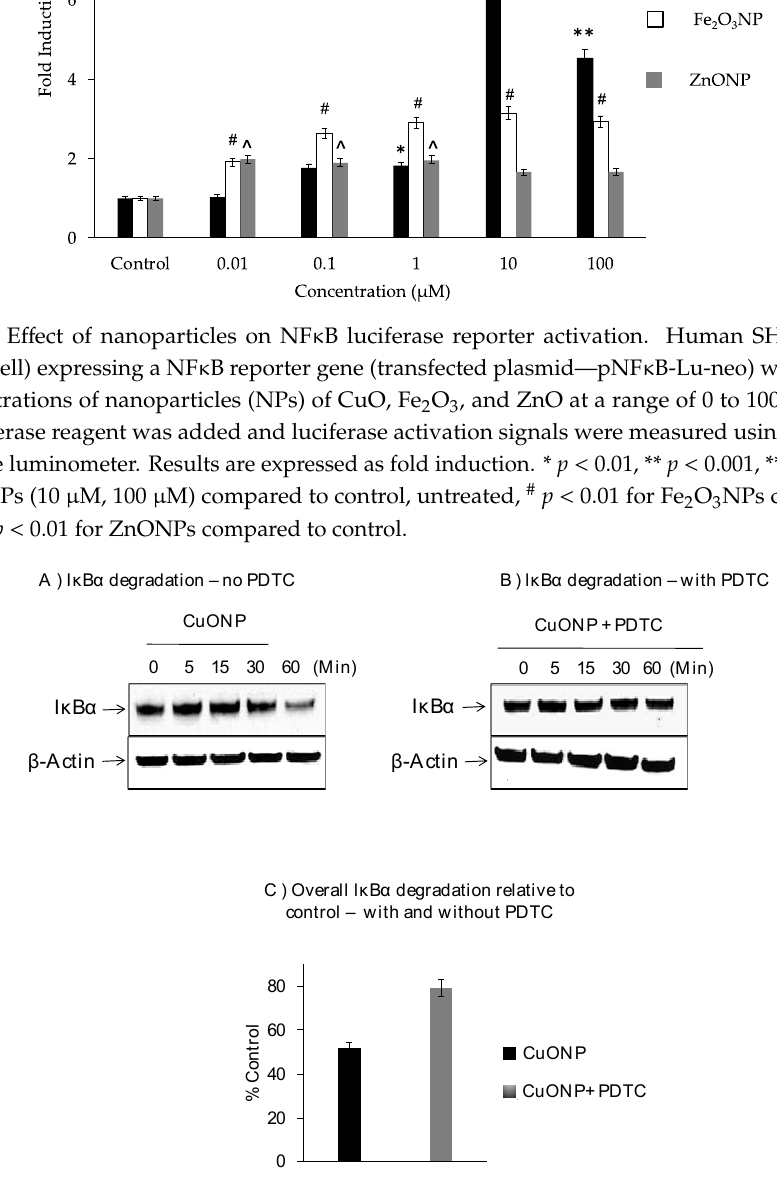
Figure 2. Effect of CuONPs on I ĸ B- α degradation. SH-SY5Y cells were plated at 2 × 10 6 cells/well (6 well plate) and exposed to CuONPs (10 μ M) in the presence or absence of the potent NF κ B inhibitor—pyrrolidine dithiocarbamate (PDTC, 50 nM) at the indicated time points. Cells were lysed, and lysates were Western blotted for the presence of I κ B- α —a protein inhibitor for NF κ B activation. Blots were collected, digitized, and quantified using a Bio-Rad VersaDoc™ Digital Imaging System (MP4000). Experiments were performed at n = 3 independent trials and representative Western blots were presented. ( A ) Western blot from cells exposed to CuONPs but not PDTC; ( B ) western blot from cells exposed to CuONPs and PDTC; ( C ) summary graph of relative degradation (compared to controls) in cells exposed to CuONPs and CuONPs and PDTC. The influence of CuONPs on APP expression was analyzed by administering treatment for 72 h on SH-SY5Y cells. The levels of APP expression were increased up to 5-fold during 6 to 24 h time periods, declining thereafter with a dose level of 10 μ M (Figure 3A). No change in the protein concentration of β - actin indicated specificity. The effects of the CuONP dose (0.01–100 μ M) on APP protein expression after 6 h of exposure in SH-SY5Y and PC12 cells were detected. TNF α (50 ng/mL) was used as a control for APP induction, and higher levels (10–100 μ M) of CuONPs resulted in increased APP expression in SH-SY5Y and PC12 cells (Figure 3B). CuONPs of 10 μ M increased APP in both cell types (SH-SY5Y and PC12). However, a 4-fold induction of APP in SH-SY5Y cells compared to 2-fold induction in PC12 cells was found. Notably, this induced change in APP expression was not as large as that of NF κ B. A study by Lv et al. showed the binding of Cu ions induced structural change in the amyloid dimer, which can induce AD pathology [66].